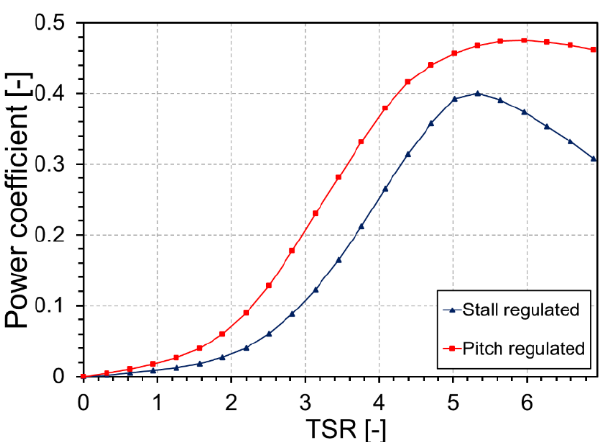
Figure 9. Aerodynamic power coefficient as a function of tip – speed ratio (TSR) in steady-state condi- tions.